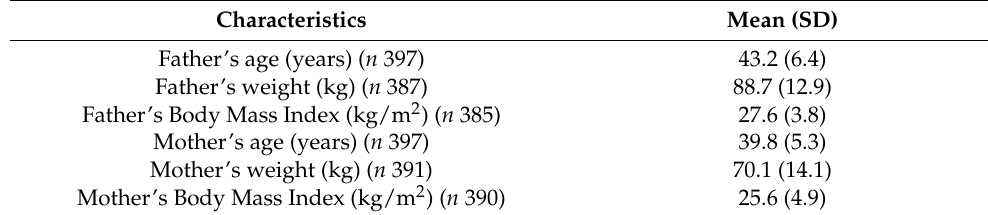
Table 1. Anthropometric characteristics of the sample.